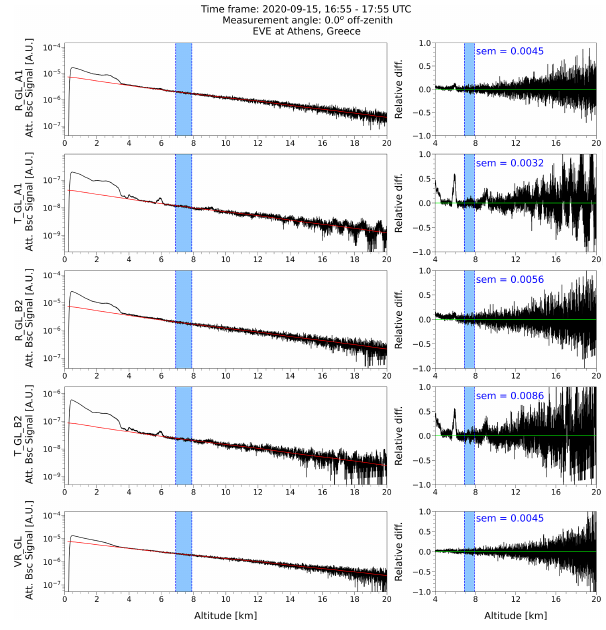
Figure B1. The Rayleigh fit test from a 1h night-time measure- ment with vertical pointing of the lidar on 15 September 2020. In the first column, the elastic unsmoothed range-corrected glued sig- nals from the reflected (R_GL) and transmitted (T_GL) channels of the A1 and B2 configurations and the inelastic unsmoothed range- corrected glued signal from the Raman channel (VR_GL) are nor- malised to the corresponding Rayleigh signals (red line) over the shaded blue region. In the second column, the relative difference of the normalised signals from the Rayleigh signals is presented, along with the standard error of the mean (SEM) of the differences inside the reference region. The blue shaded region denotes the selected reference region for Rayleigh atmosphere (7 . 4 ± 0 .